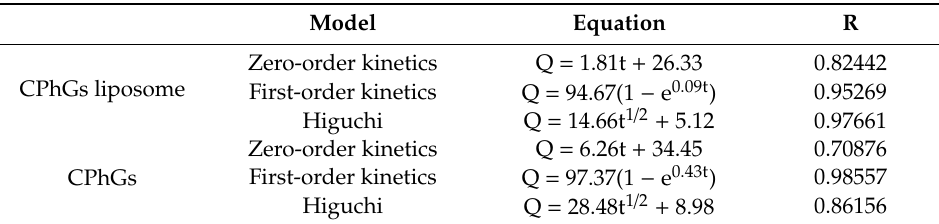
Table 1. The results of fitting equation and coe ffi cients.